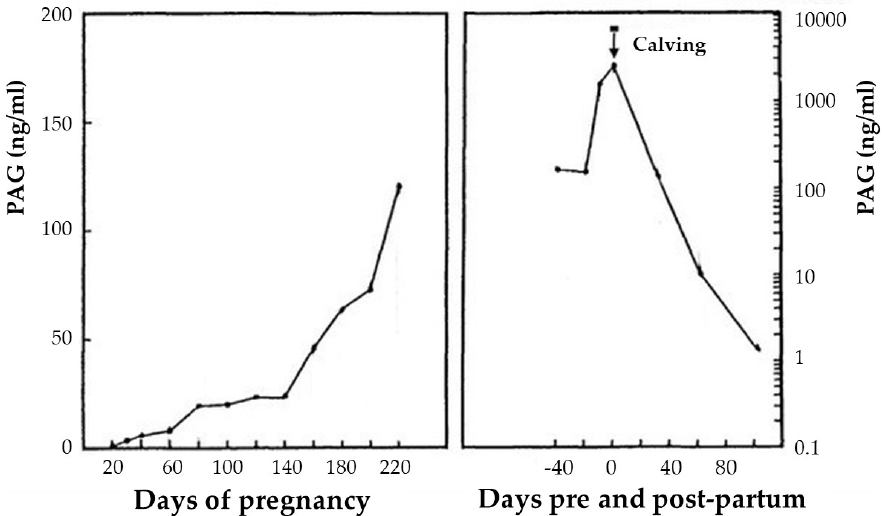
Figure 1. Pregnancy-associated glycoprotein (PAG) plasma profile of a cow during pregnancy and the post-partum period. Adapted from Zoli et al. [16].